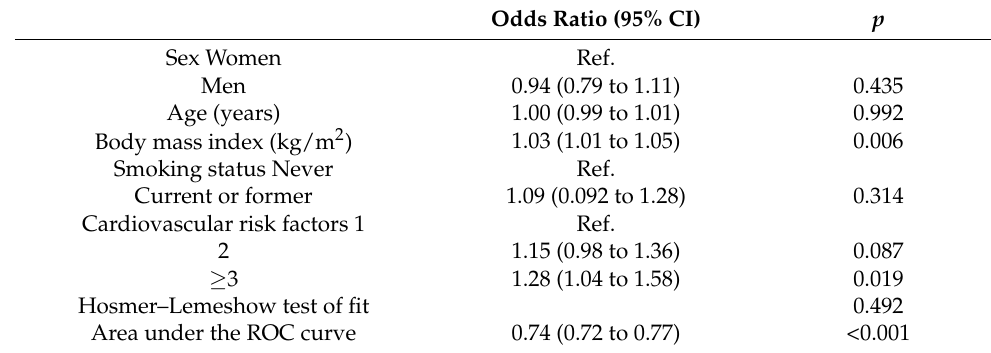
Table 4. The multivariable logistic regression model for high AGEs in subjects with